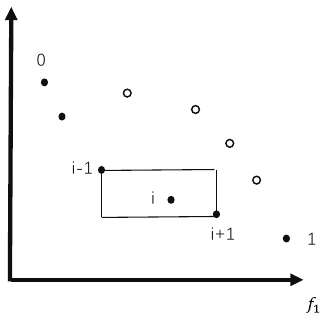
Figure 7. The crowding distance about the i-th solution. The average distance between the two points on either side of point i is calculated; based on each objective function, the vertices of the rectangle are determined by their nearest neighbors, i.e., i − 1 and i + 1, and the length of the cube is equal to the congestion factor of the solution in the graph. This figure is adopted from